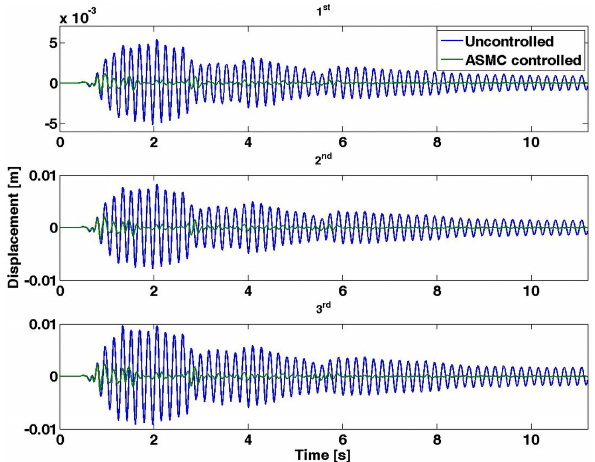
Figure 9. Displacement responses of the first, second, and third floors to the 1940 El Centro